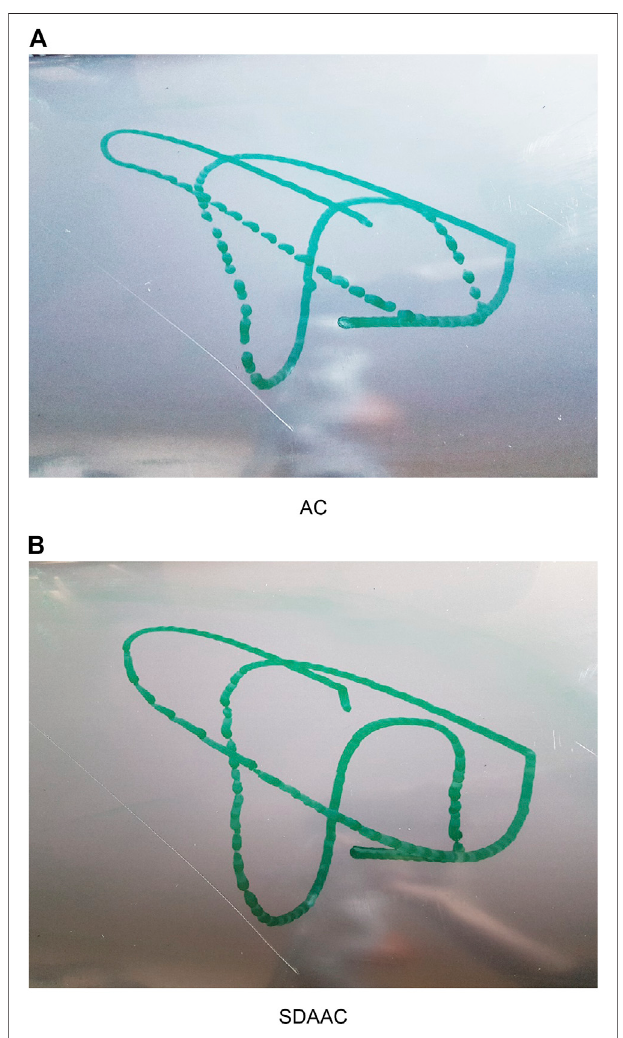
FIGURE 8 | Experimental results (drawings on the pipe) for sinusoidal base disturbance.